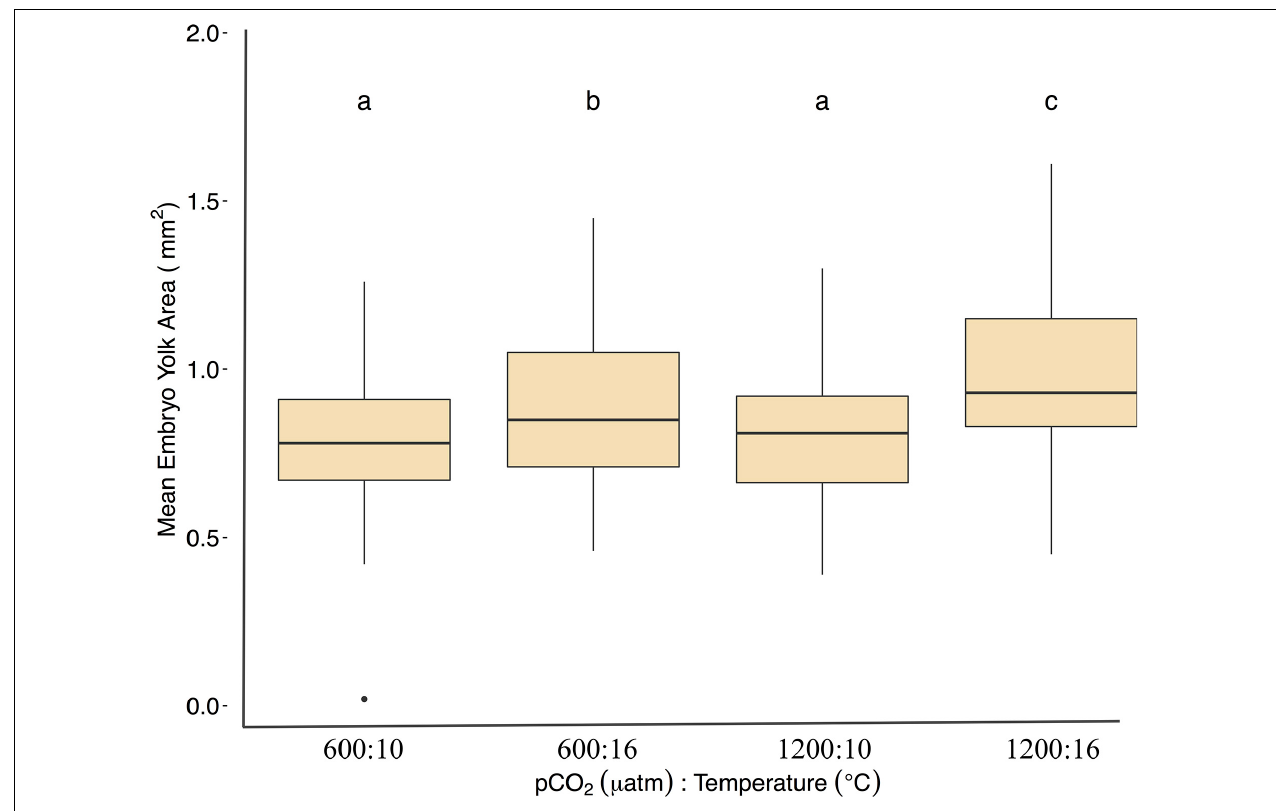
FIGURE 3 | Mean yolk area (mm 2 ) for Pacific herring embryos under treatment conditions. Data are from images collected over 2 days before the developing embryo obscured the yolk sac (days 9–10 at 10 ◦ C and 3–4 at 16 ◦ C. Data are based on the mean ± 1 SD of (n) measurements: 600 µ atm:10 ◦ C ( n =